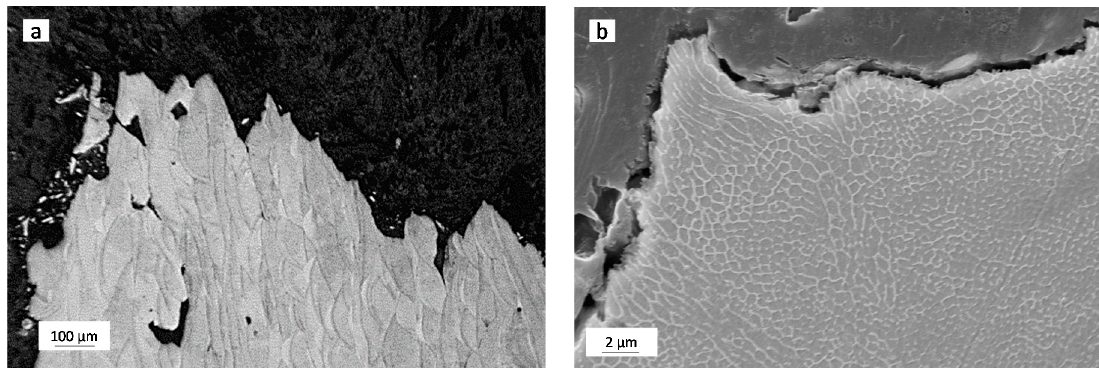
Figure 12. Low ‐ magnification views of longitudinally ‐ sectioned broken tensile specimens close to the fracture line. ( a ) As ‐ built sample, optical image; and ( b ) 460 °C peak ‐ aged sample, SEM image . fracture line. ( a ) As-built sample, optical image; and ( b ) 460 ◦ C peak-aged sample, SEM